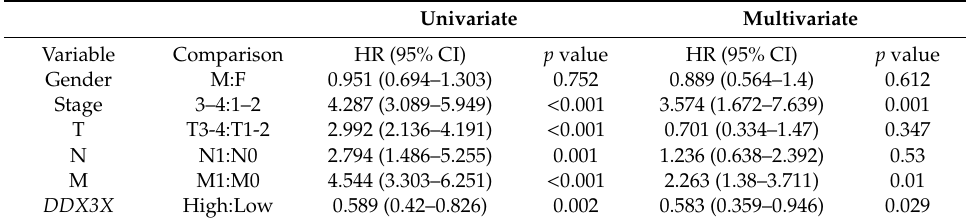
Table 2. Cox univariate and multivariate regression analysis of pathological stage, TNM prognostic factors and DDX3X expression for overall survival in 500 renal cell carcinoma patients. Univariate